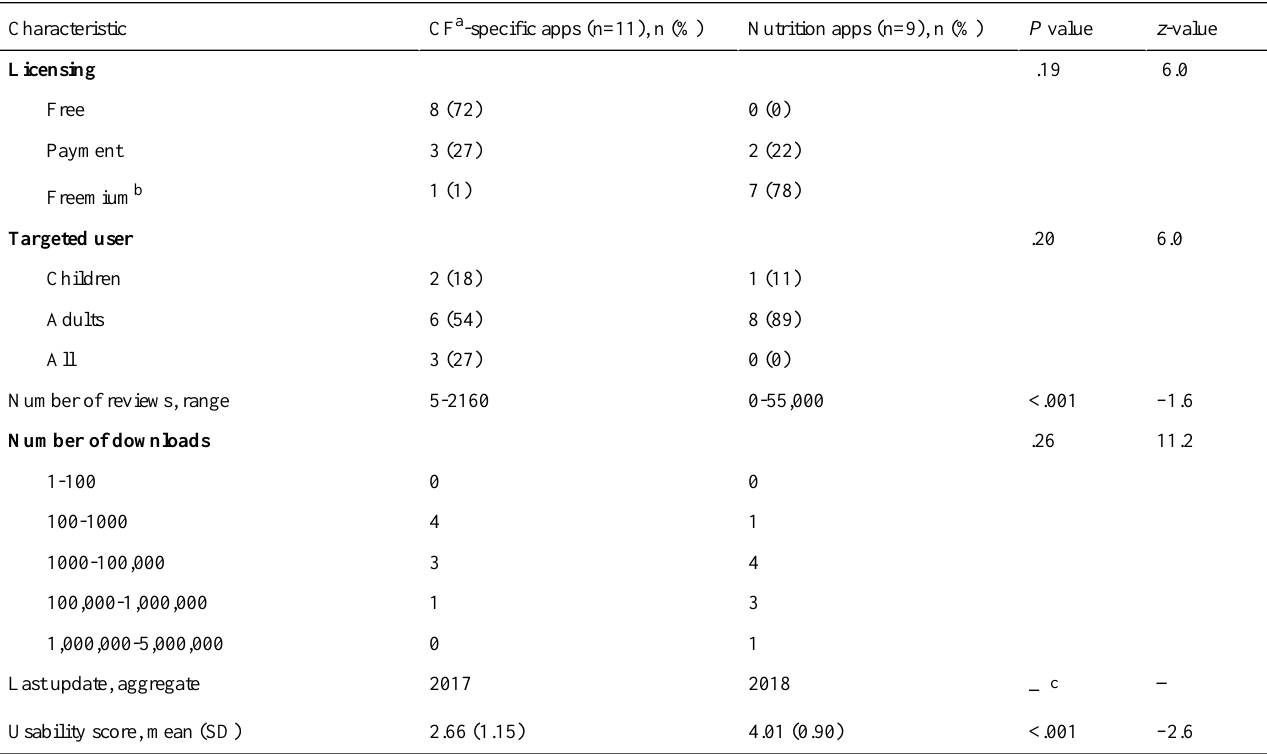
Table 2. Comparative analysis of available apps for cystic fibrosis management and